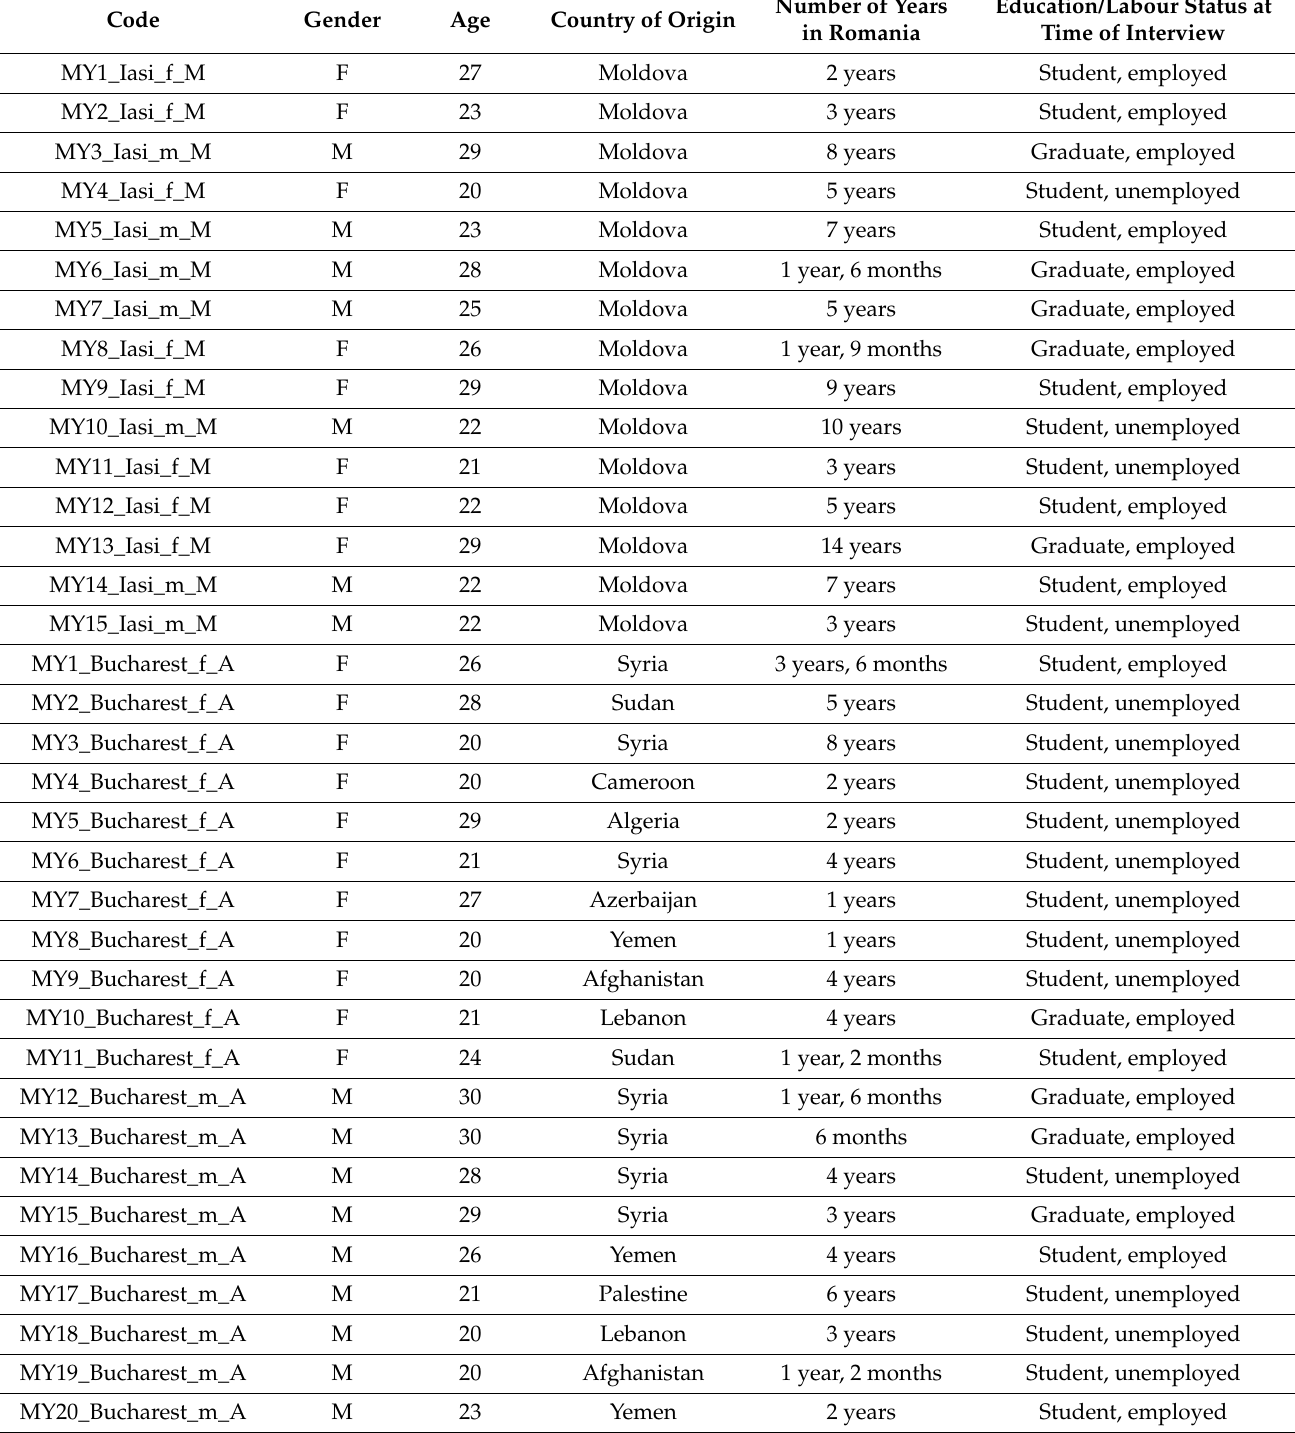
Table A1. Description of participants in the semi-structured